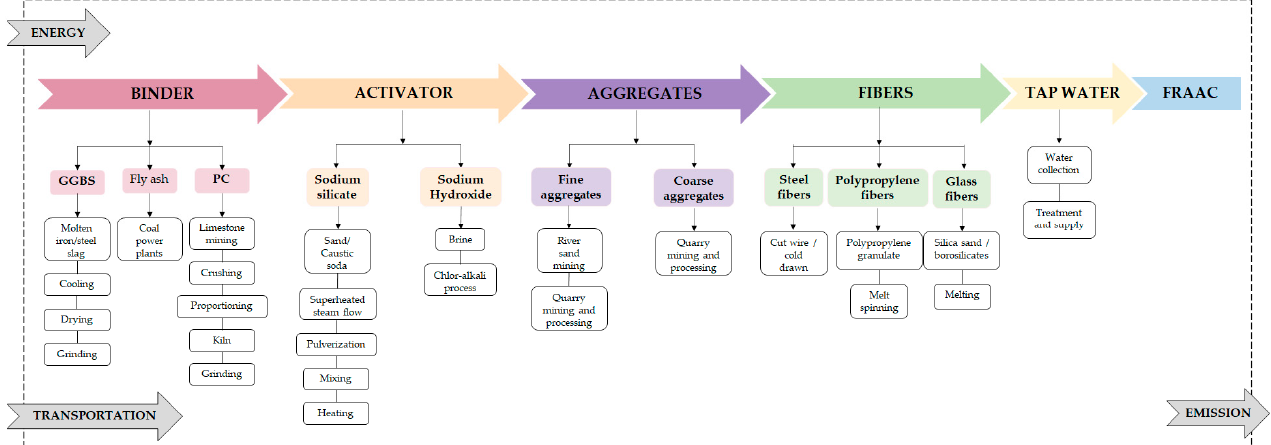
Figure 3. System boundary of FRAAC for cradle-to-gate LCA. Table 3. Unit cost and freight distance of raw